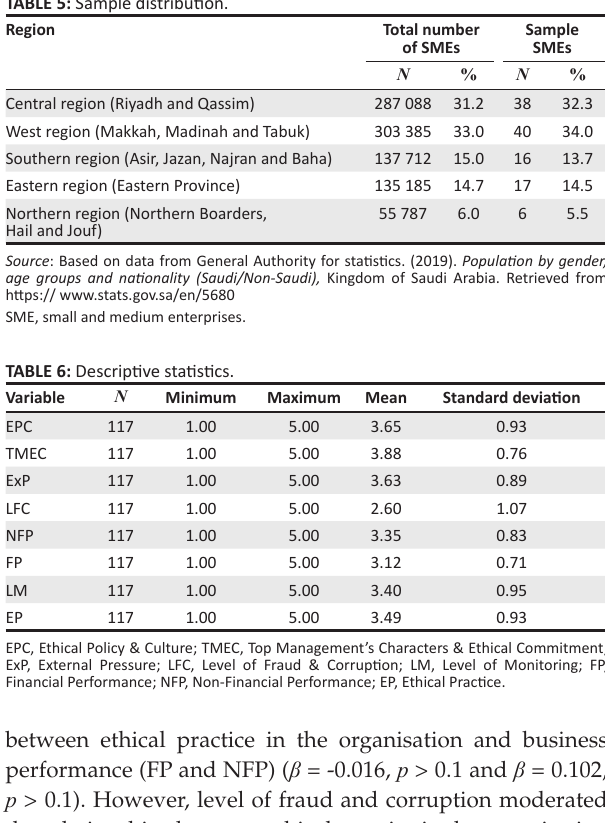
TABLE 4: Output of HTMT. Constructs